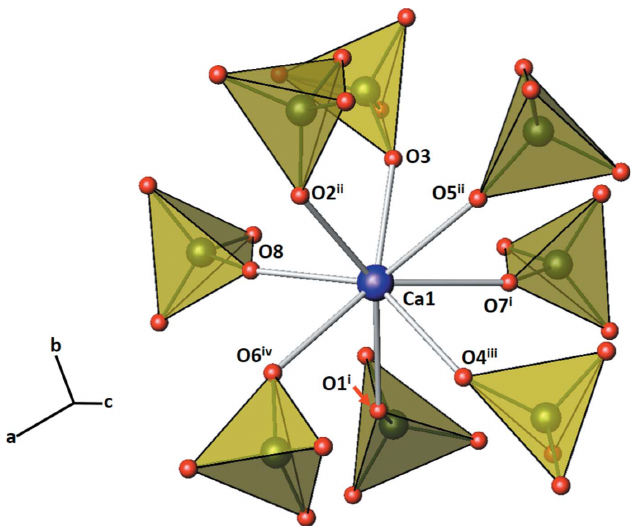
Figure 3 The local environment of the Ca 2+ cation (purple sphere) surrounded by ClO 4 (cid:3) tetrahedra (yellow). [Symmetry codes: (i) (cid:3) x + 1, (cid:3) y + 1, (cid:3) z + 1; (ii) x , (cid:3) y + 3 , z + 1 ; (iii) (cid:3) x + 1, y (cid:3) 1 2 2